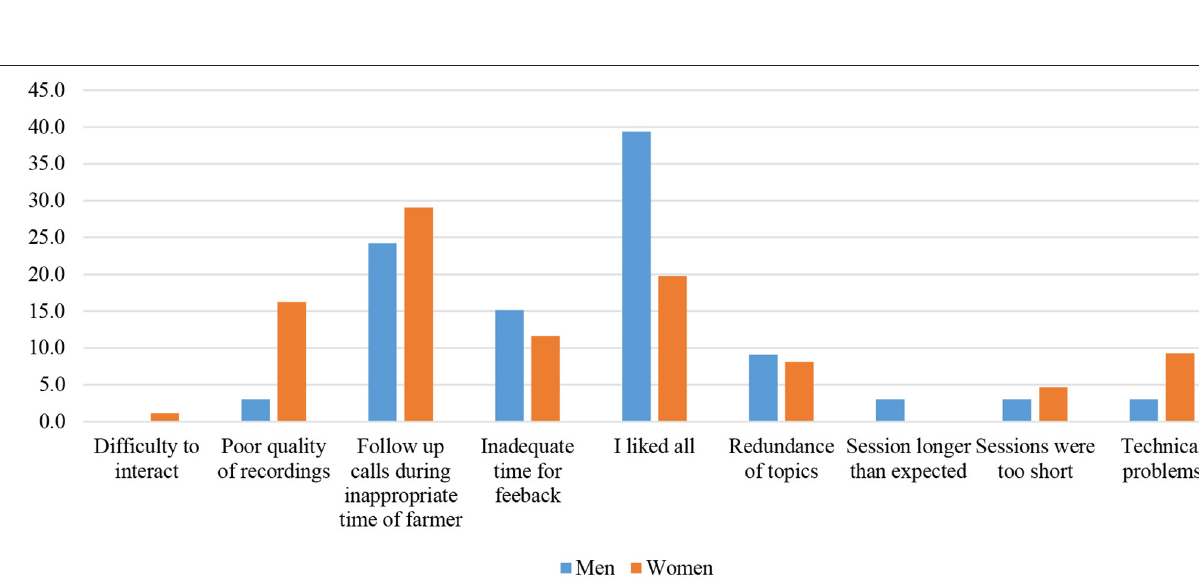
FIGURE 6 | What in particular did you like about the mobile training? ( n = 119).